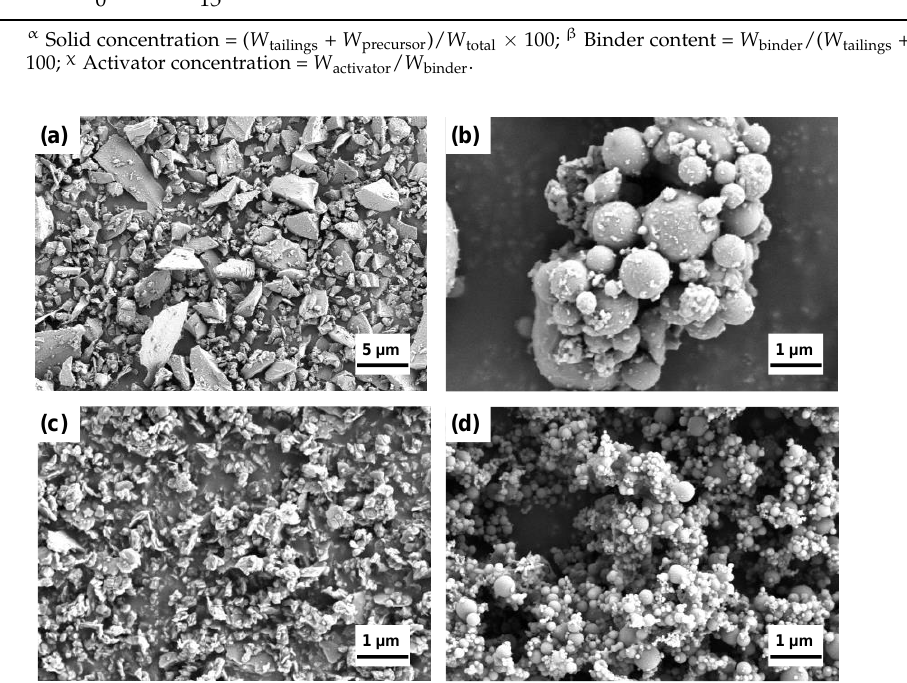
Table 3. Details of the mix proportions.